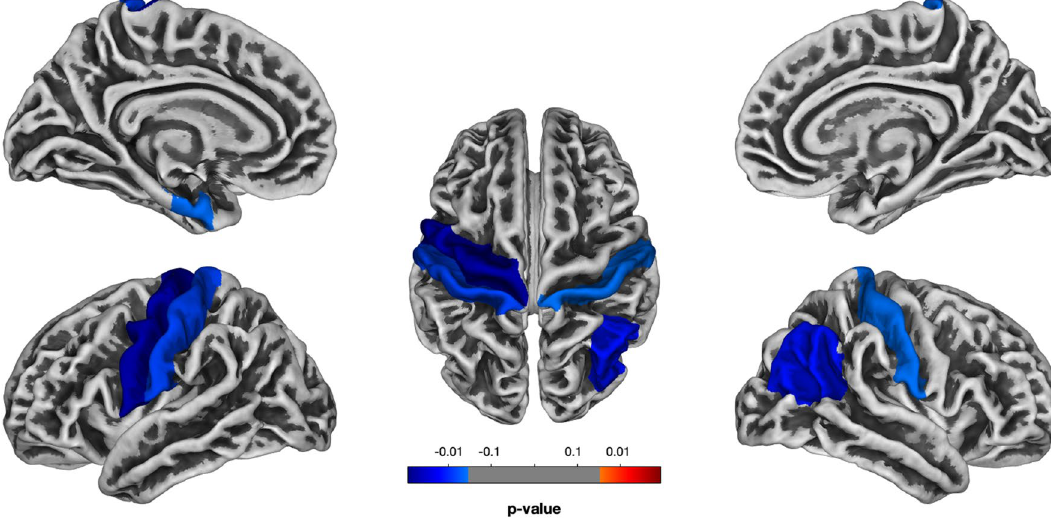
Figure 6. The statistical map for the whole-brain analysis in Gyrification Index (difference between ASD and TD groups of children, Holm-Bonferroni corrected p < 0.05). Negative p -values refer to the inverse contrasts (ASD >